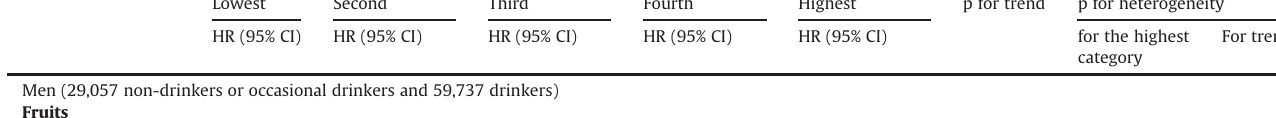
Table 4 Pooled analysis of overall cancer incidence according to quintile of fruit and vegetable consumption, strati fi ed by alcohol drinking, in Japanese men and women. Lowest Second Third Fourth Highest p for trend p for heterogeneity